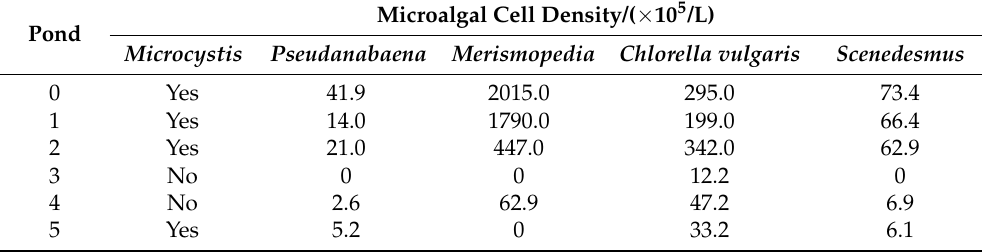
Table A1. Typical types and average densities of microalgal cells in each pond in the summer of the third experimental year (1).